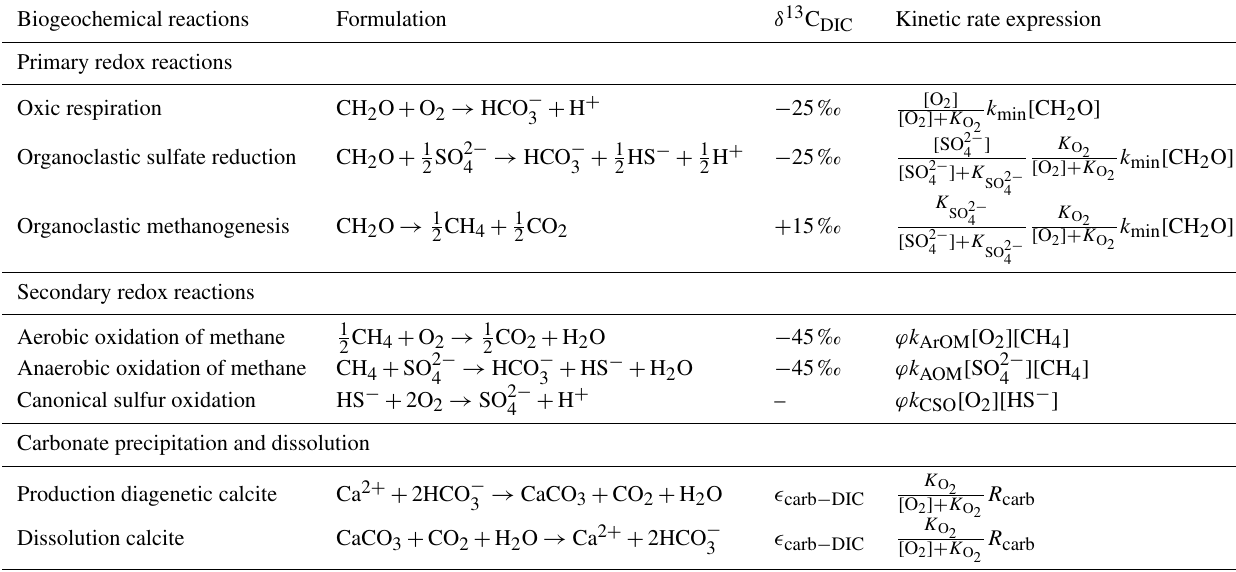
Table 2. Biogeochemical reaction equations and kinetic rate expressions. Biogeochemical